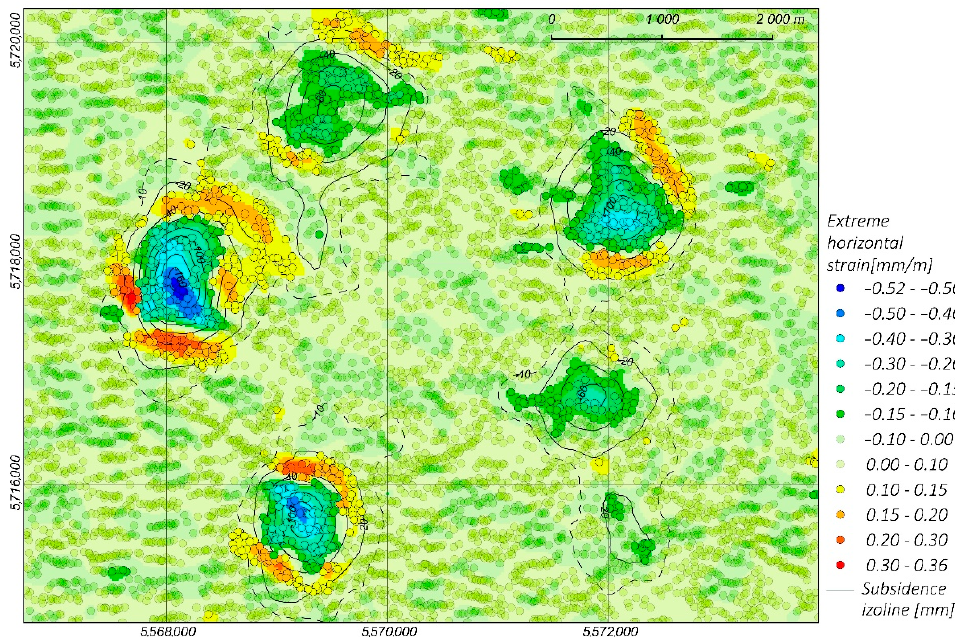
Figure 8. The distribution of extreme horizontal strain values and isolines of vertical displacements in the case study. The ‘ − 10 mm’ isoline is represented by the dashed line, whereas isolines between ‘ − 20 mm’ and ’20 mm’ are denoted by continuous lines every ’20 mm’.